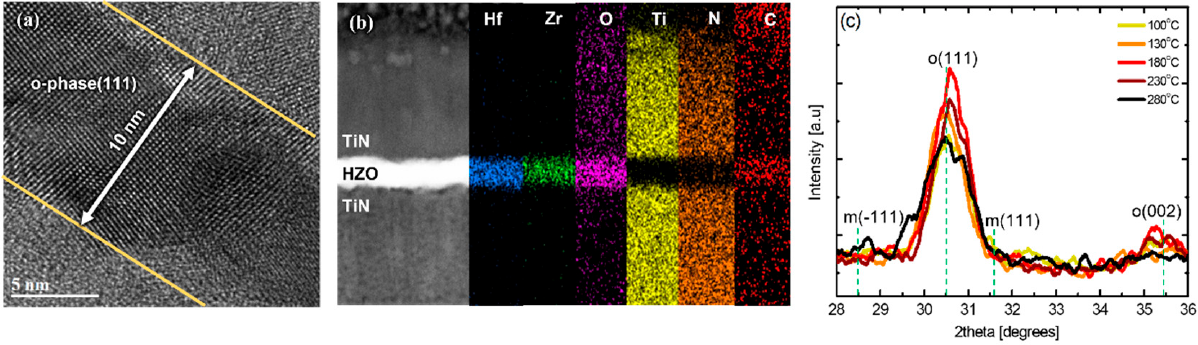
Figure 3. ( a ) Cross − sectional high − resolution TEM (HR − TEM) image and ( b ) EDS composition cross-sectional profile and ( c ) XRD pattern change with respect to substrate temperature in the range of 100–280 ◦ C for PEALD HZO thin films deposited at 180 ◦